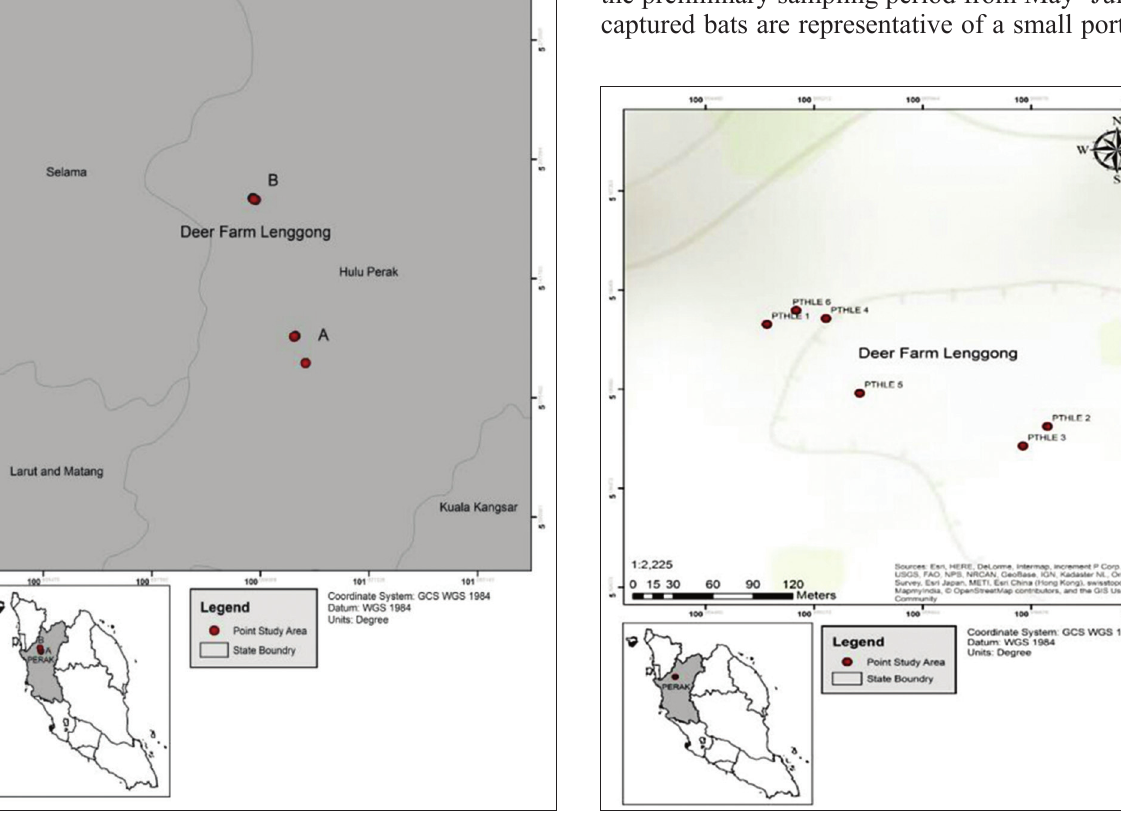
Figure-1: Map of Lenggong Livestock Breeding Center. Figure-2: Map of sampling